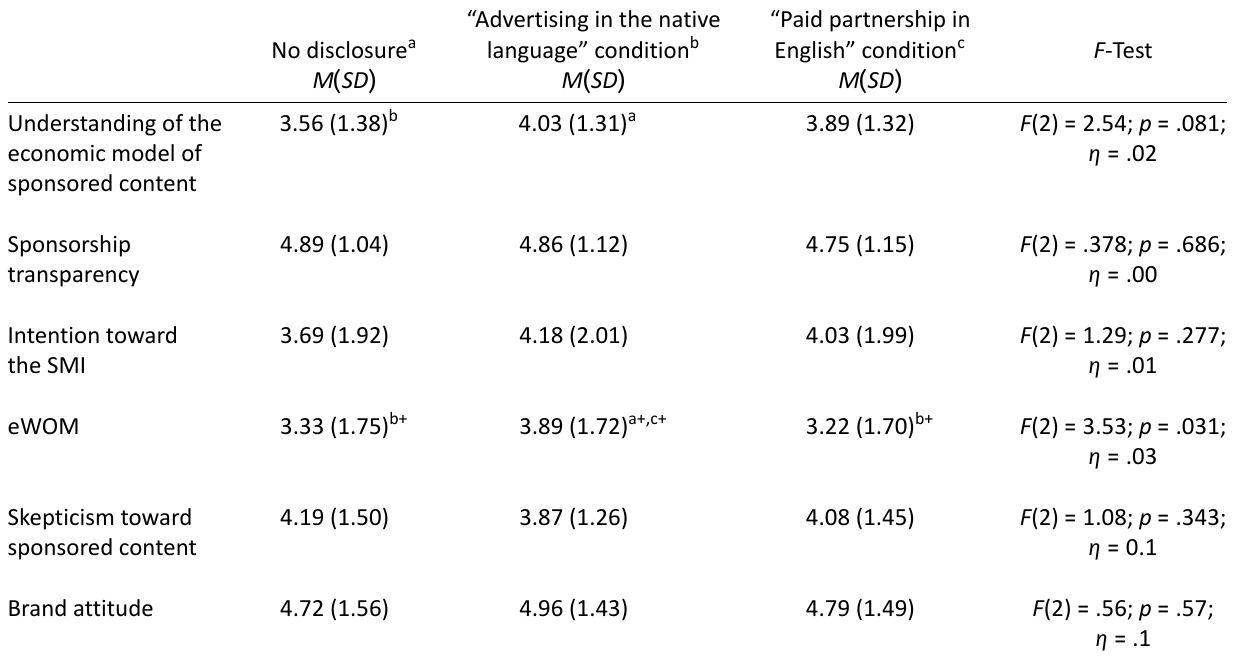
Table 1. MANOVA. “Advertising in the native “Paid partnership in No disclosure